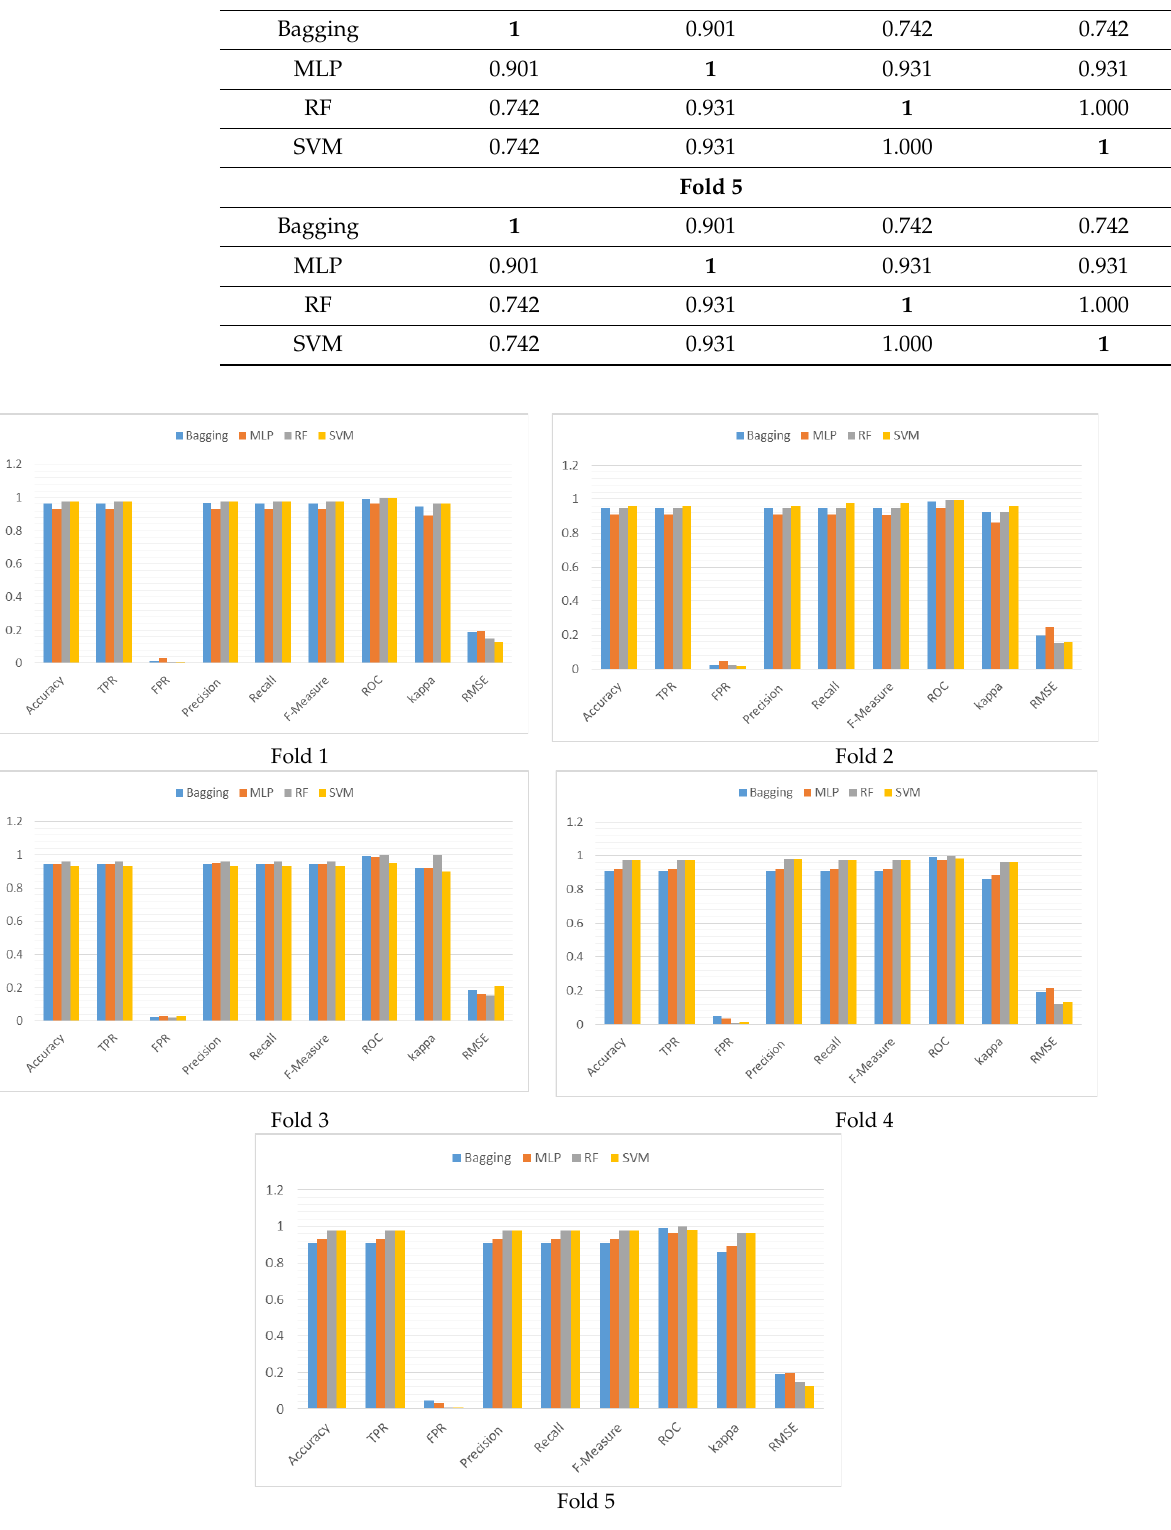
Figure 3. Graphical representation of the performance comparison of the classifiers for each fold of the 5-fold cross validation in terms of the performance metrics.